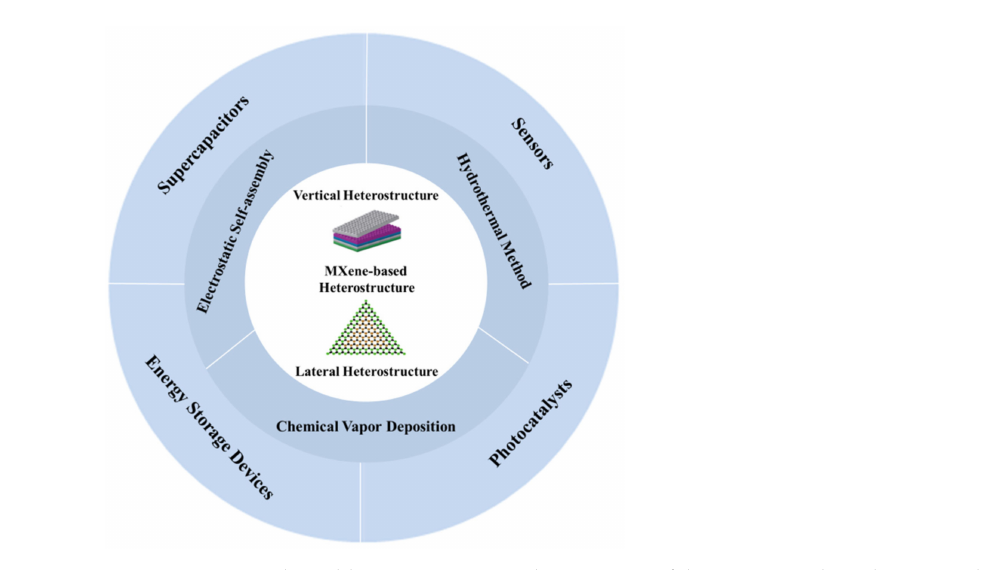
Figure 1. MXene-based heterostructures: the structure, fabrication, and application. The inserted figures are reprinted with permission from Ref. [40]. 2013, Springer Nature., and Ref. [52]. 2018, Springer